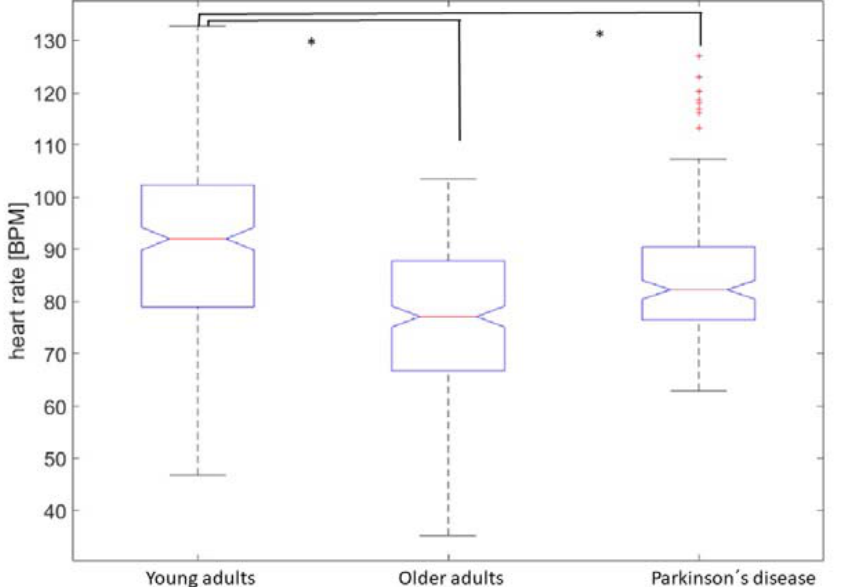
Figure 2. Averaged heart rate of all conditions in all three groups. The means of the older adult group and the Parkinson´s disease group are significantly (*) different from those of the young adult group. The error bars are the SEM, i.e., the standard error of the means used for the Anova to test for equality.